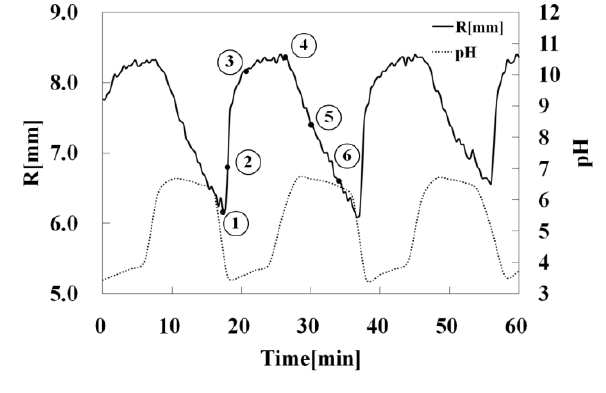
Figure 8. The time series of pH (discontinuous line) and R (solid